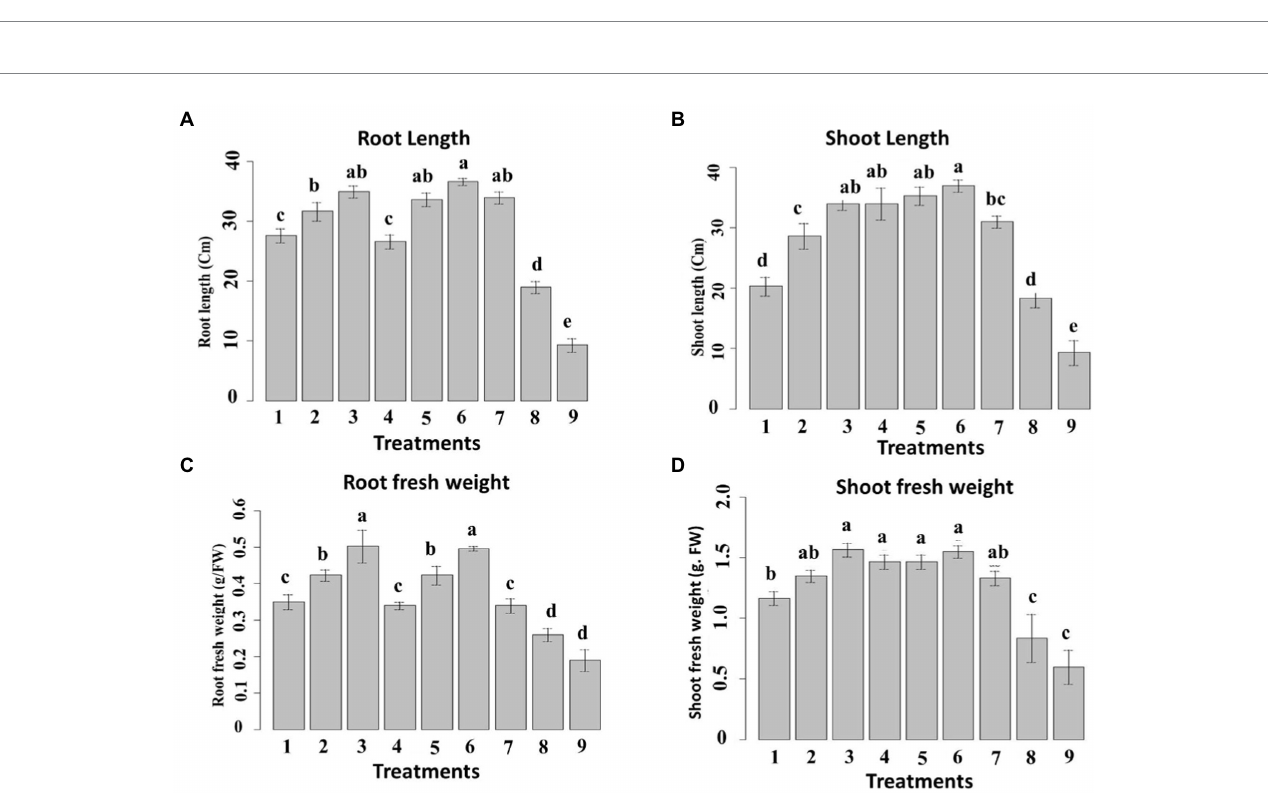
FIGURE 9 Effect of six nanoemulsions treatments on (A) the root and (B) shoot length, (C) root fresh weight, and (D) shoot fresh weight of maize samples: 1–6 are 0_ T80, 5_T80, 10_T80, 0_T20, 5_T20, and 10_T20, respectively. 7–9 are chemical fungicide, untreated control, and infected control, respectively. The values were recorded on seedlings at 14 DPS. Values marked with the same letters are not statistically different according to post hoc test DMRT at p ≤ 0.05.